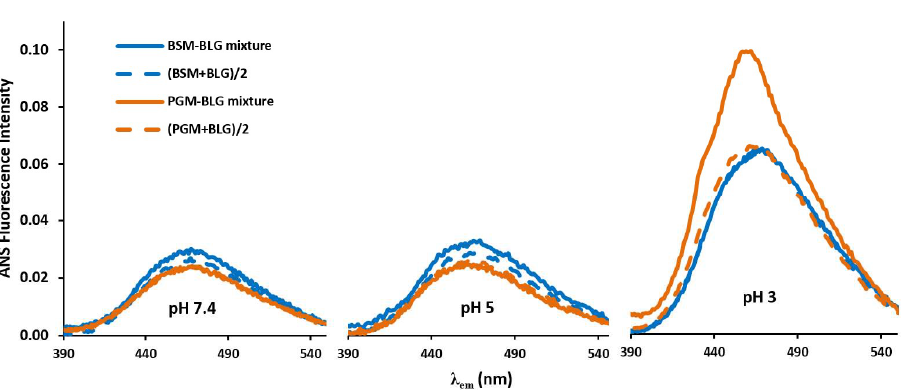
Figure 7. The comparison of the extrinsic fluorescence intensity of the BSM–BLG and PGM–BLG mixtures with their calculated spectra (mucin + BLG)/2 using the spectra of pure BLG and mucins.